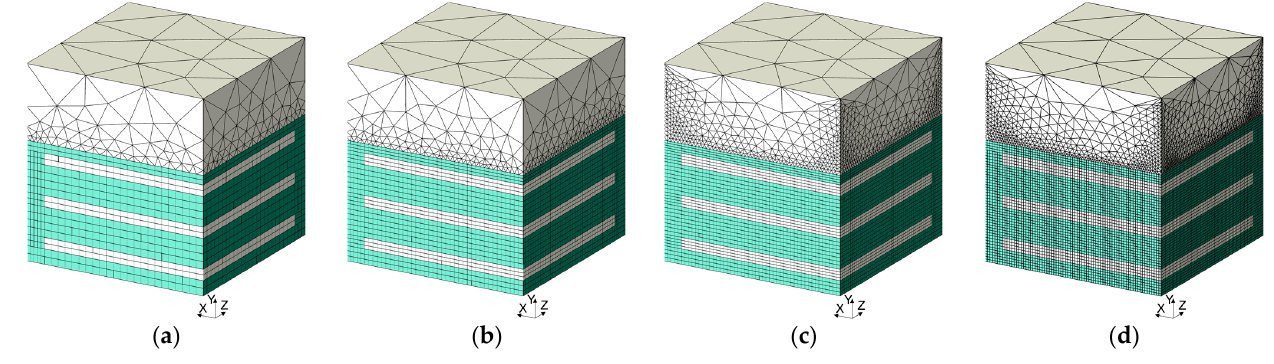
Figure 3. High bearing—finite element mesh: ( a ) M0; ( b ) M1; ( c ) M2; ( d ) M3.